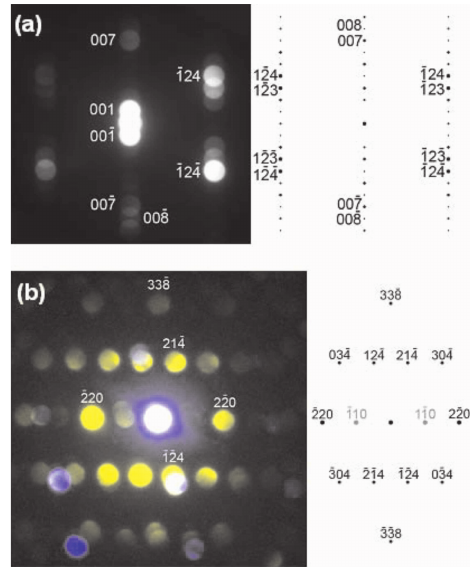
Figure 15 . (a) [210] CBED pattern from a Mn corresponding simulation, and (b) [443] CBED pattern from a Mn corresponding simulation (in the experimental pattern spots from the Si matrix appear blue and those from the precipitate are yellow). (Reprinted with permission from Ref. [69]. Copyright 2008, American Institute of